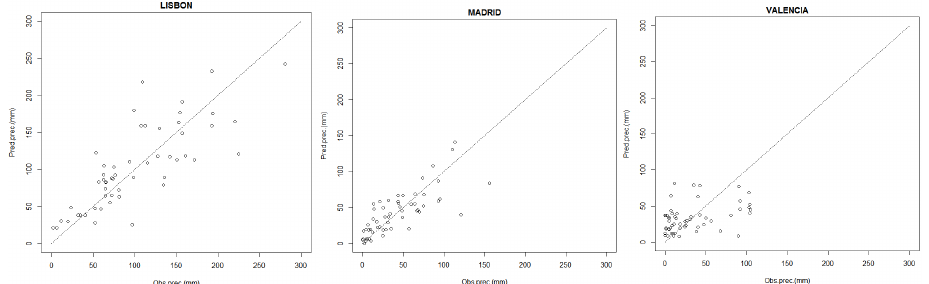
Fig. 10. Scatterplot of January total precipitation between observed and modelled values (1948–2003) for Lisbon, Madrid and Figure 10. Scatterplot of January total precipitation between observed and modeled values (1948-2003) for Lisbon, Madrid and Valencia